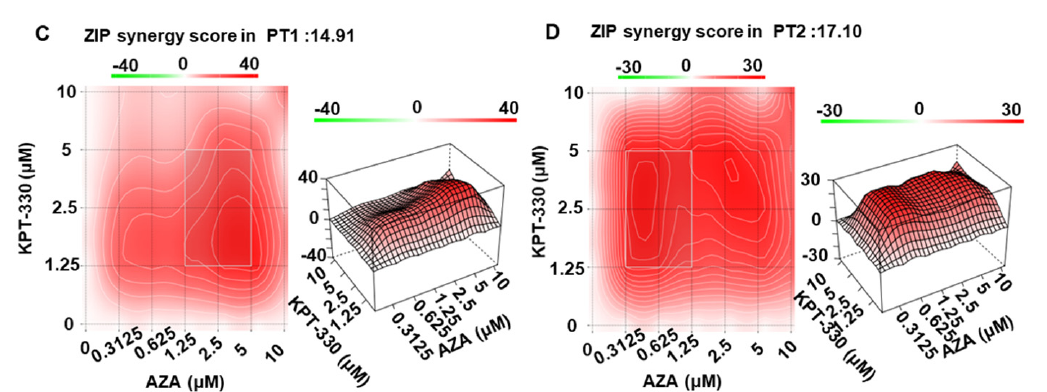
Figure 7. Synergistic effect of KPT-330 with AZA on cell growth arrest in primary cells from the AML patients. Effect of drug treatment (DMSO, KPT-330, AZA, and combo) on the cell growth ar- rest and CalcuSyn analysis in primary cells from AML patient 1 (PT1, A). Effect of drug treatment (DMSO, KPT-330, AZA, and combo) on the cell growth arrest and CalcuSyn analysis in primary cells from AML patient 2 (PT2, B ). Bliss analysis for the synergistic effect in PT1 ( C ) and PT2 ( D ) using the SynergyFinder Web application. Synergy score: < − 10, antagonistic; from − 10 to10, additive; >10, synergistic. *** p < 0.001